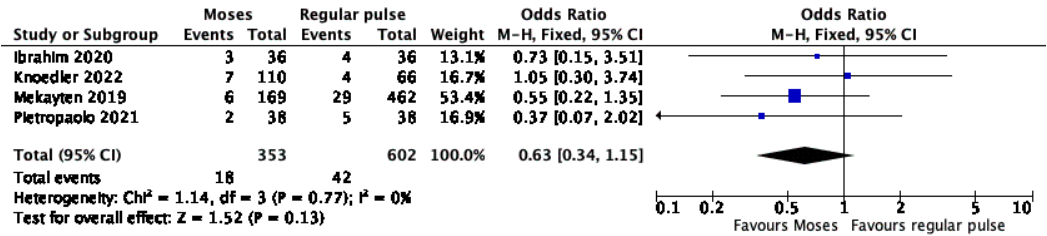
Figure 4. Forest plot of the meta-analysis comparing fragmentation time between Moses versus regular pulse modulation [18,35].